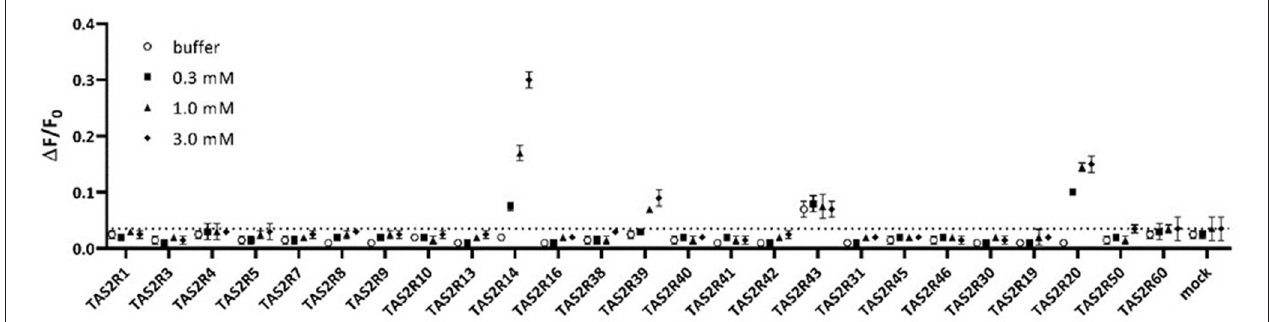
FIGURE 1 | Assay buffer (white circles) or 0.3mM vanillin (black filled squares), 1mM vanillin (black-filled triangles), and 3mM vanillin (black filled diamonds) tested on all human TAS2Rs. Only TAS2R14, TAS2R20, and TAS2R39 showed concentration-dependent specific activation. Data are plotted as 1 F/F0 above time, where 1 F/F0 are RFU normalized for the basal fluorescence at time